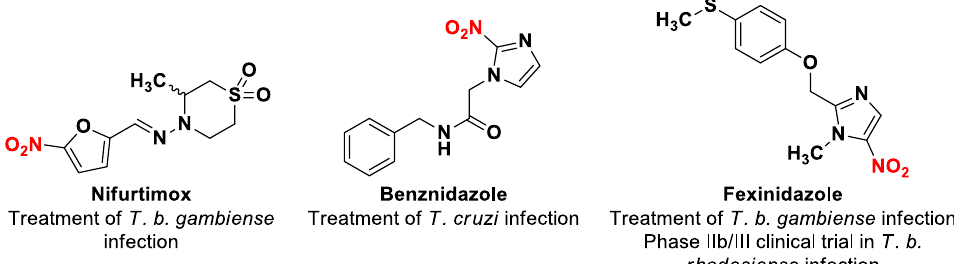
Figure 1. Structures of nitroheterocyclic drug-compounds that are substrates of the parasitic type 1 nitroreductases.